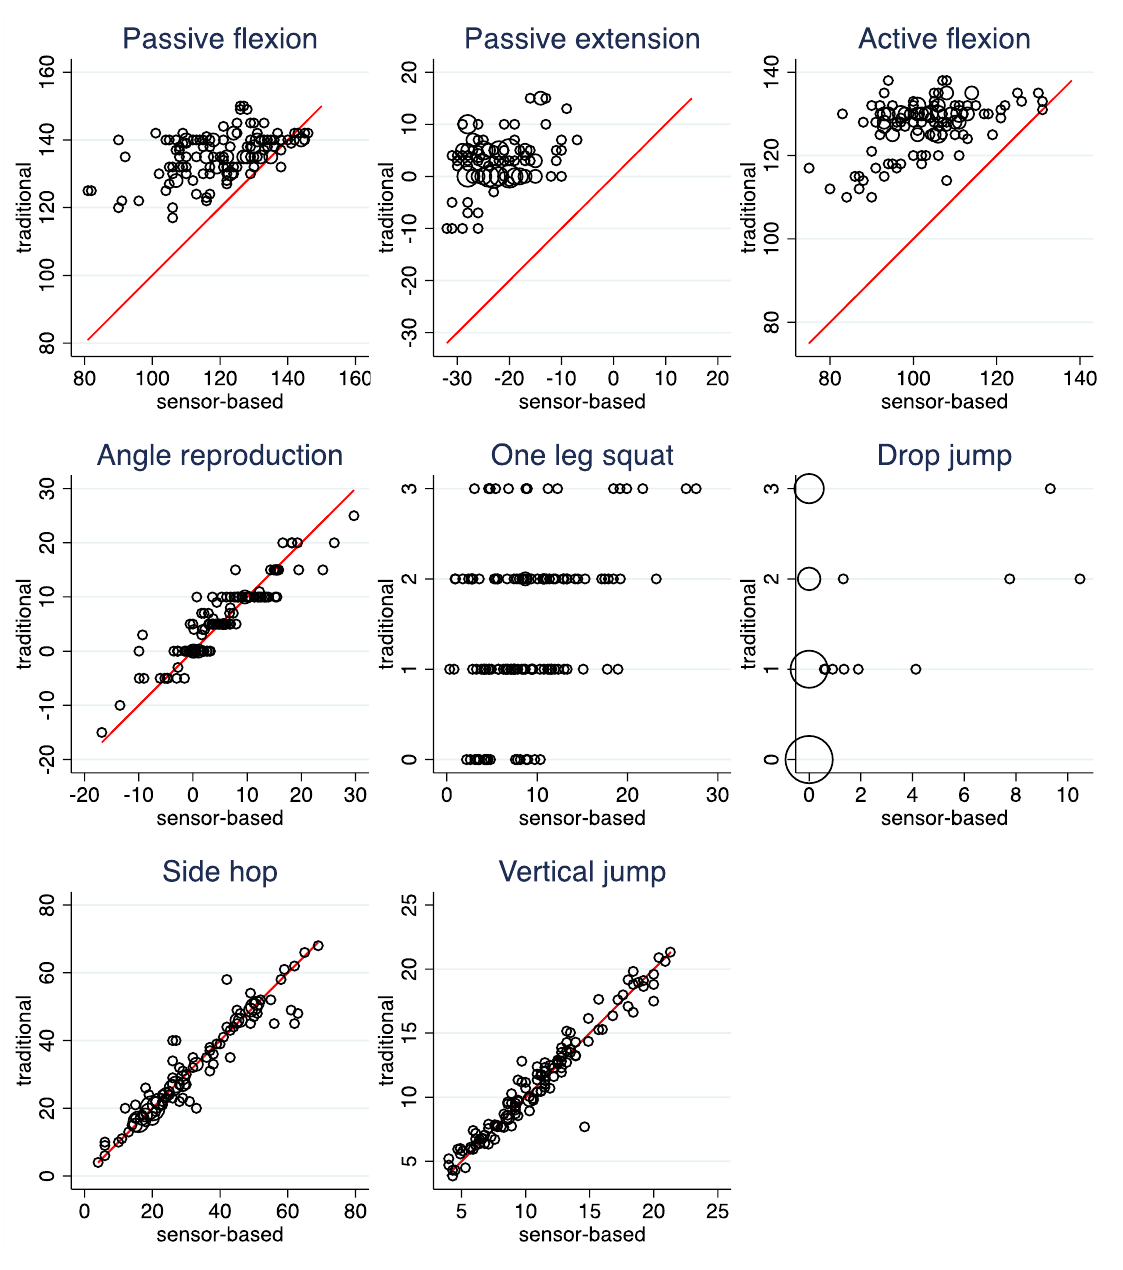
Figure 3. Scatterplots of the raw measurements comparing the sensor-based and the traditional assessment. Observations from both legs are included in the same scatter plot. The area of the circles is proportional to the number of observations. The line indicates equality of the two measurements.